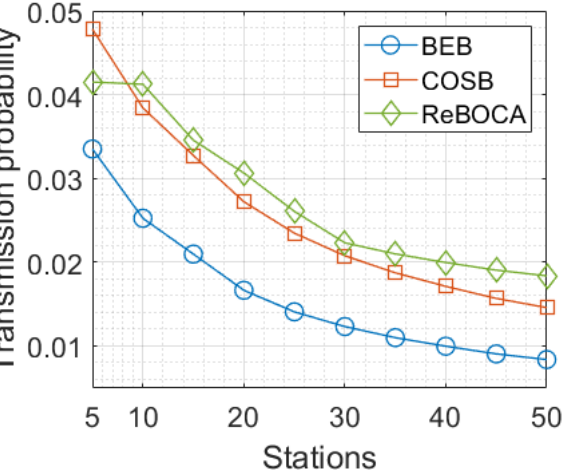
Figure 4. Comparison of collision probability ( p ) among BEB, COSB, and ReBOCA due to change in network density.